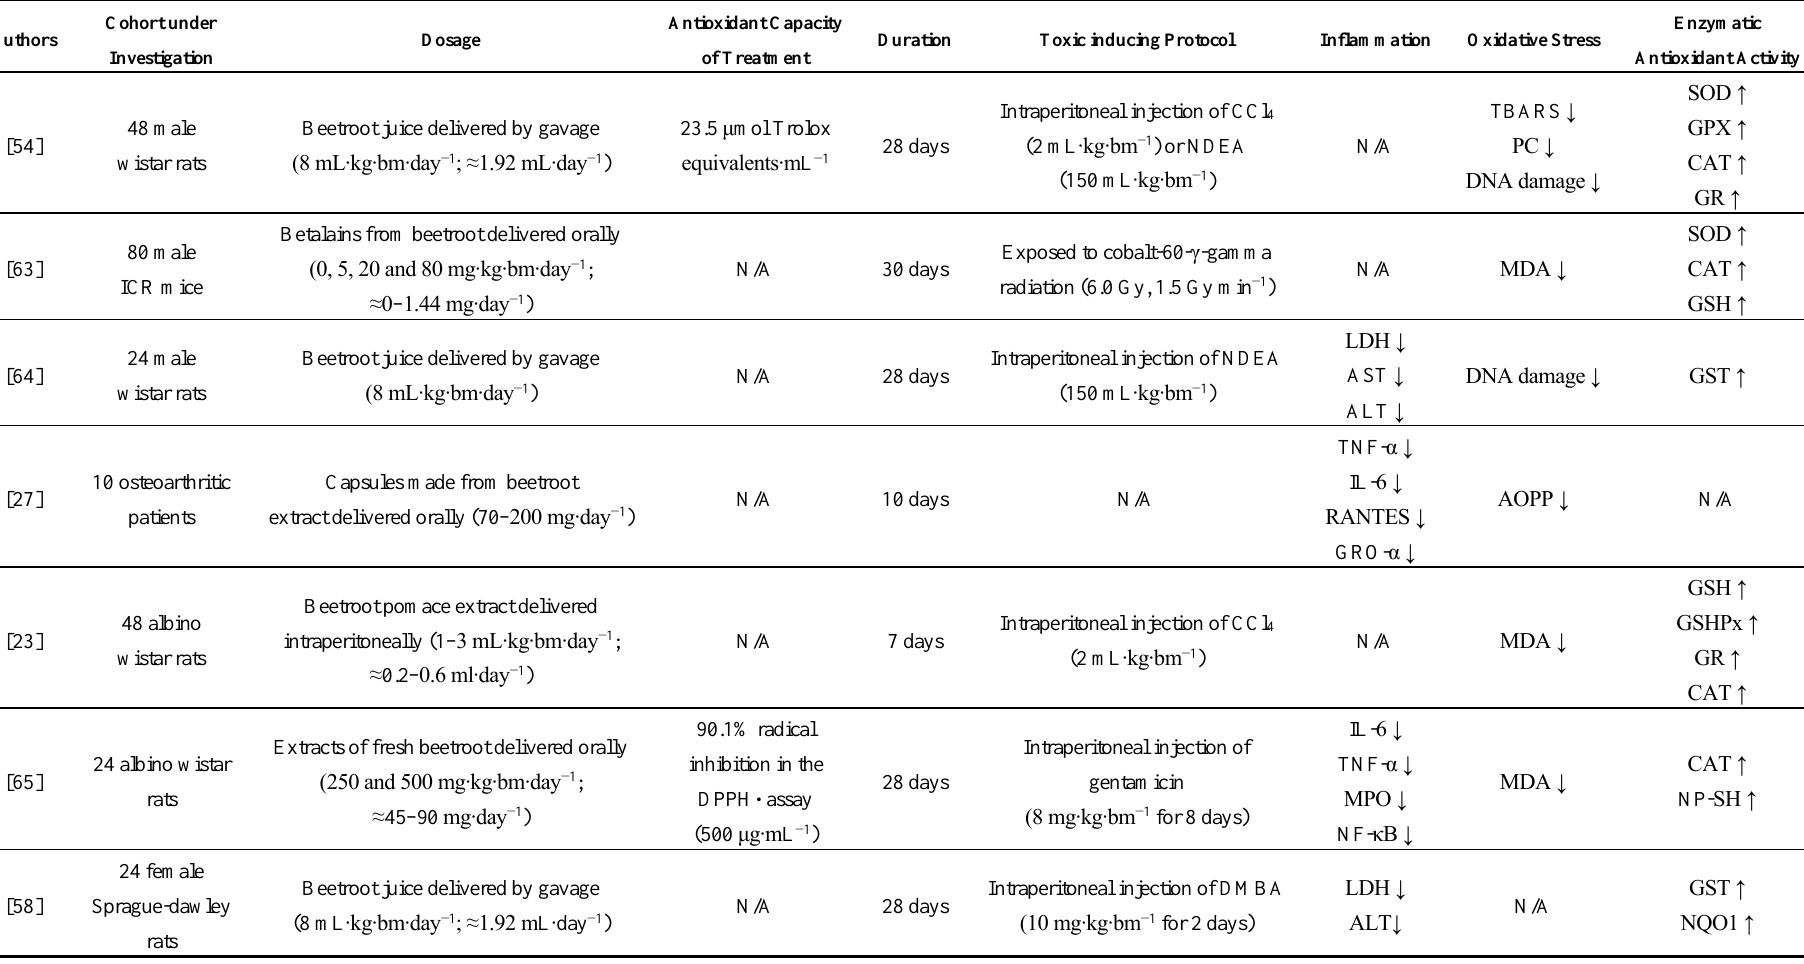
Table 1. Overview of human and animal studies investigating the effects of beetroot and its derivatives on oxidative stress and inflammation.